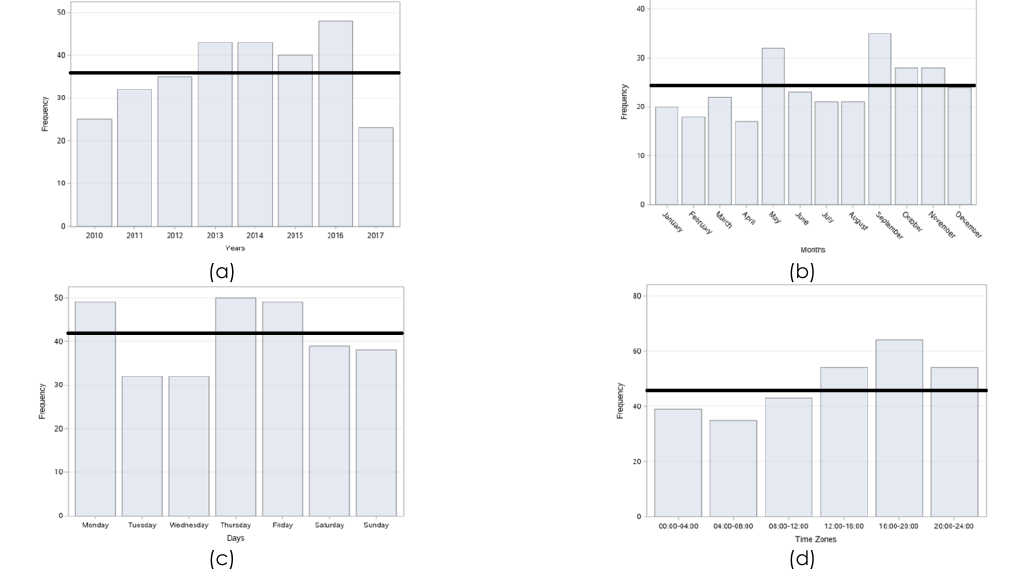
Figure 10. Bar graphs of traffic accidents on Halaskargazi Street in Şişli district: (a) By years; (b) By months; (c) By days; (d)